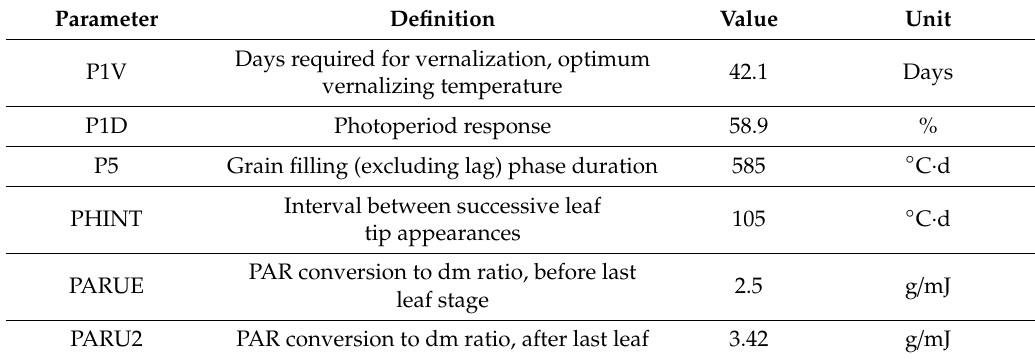
Table 5. Cultivar coe ffi cient localization results of the DSSAT-CERES-Wheat model.